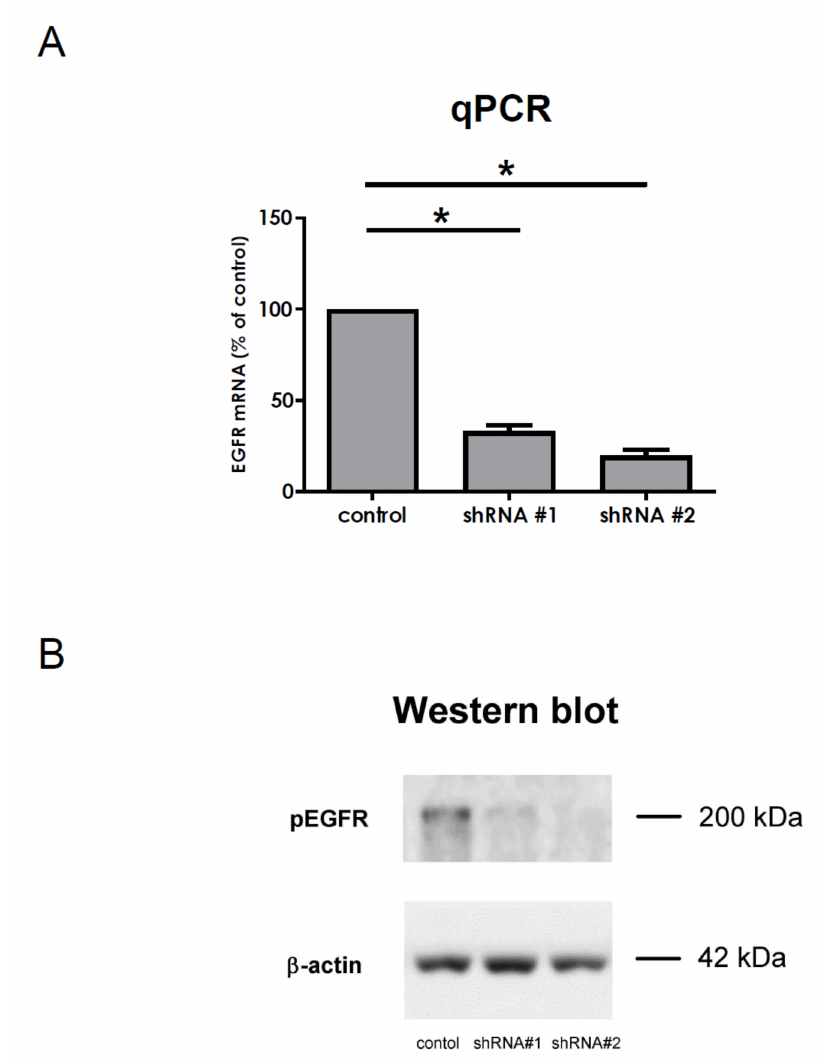
Figure 6. Silencing EGFR expression with shRNA constructs via lentiviral infection. VSMCs were infected with either shEGFR#1 or shEGFR#2 lentiviral constructs for 48 h. Control-group cells were infected with a lentivirus coding-scrambled shRNA sequence. ( A ) EGFR gene expression levels were measured by a real-time PCR. Mean values ± SE are shown. Significance was calculated with an ordinary one-way ANOVA test (* p < 0.05). ( B ) In the image, 5 min of 50 ng/mL EGF stimulation- induced phospho-EGFR levels were measured by Western blot analysis. Anti- β -actin staining was used as a loading control. The Western blots shown are representative of three independent experiments ( n =